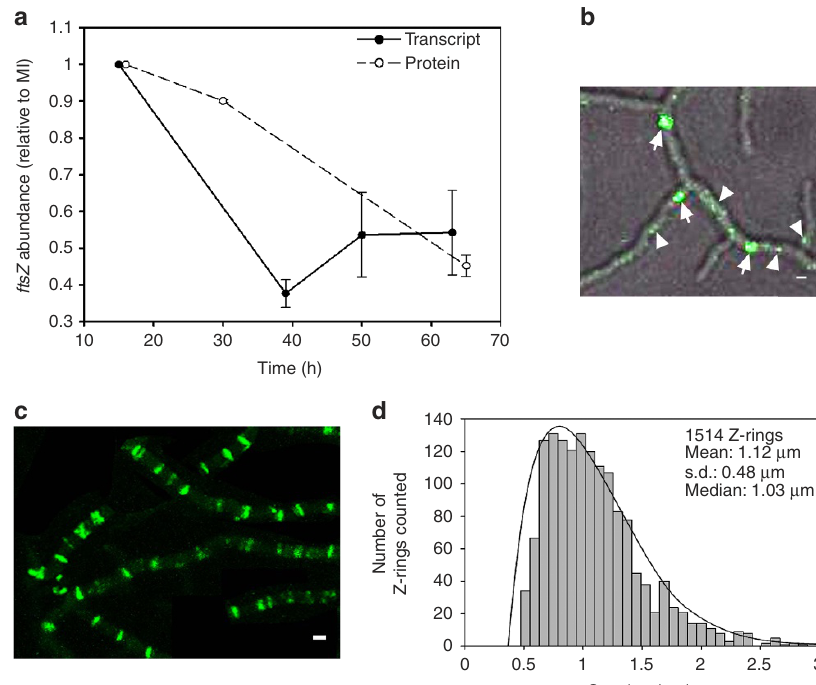
Figure 4 | ftsZ gene expression, protein abundance and cellular localization. ( a ) qRT–PCR analysis of FtsZ mRNA (solid line) and FtsZ protein abundance (dashed line). The average values of three biological replicates are presented (with SD). The MI sample (15h in transcriptomics, 16h in proteomics) was used for normalization and consequently has a value of 1 and an s.d. of 0. All abundance values were significantly different with respect to the 15-h sample ( P value o 0.05; limma analysis 43 for protein; analysis of variance with Turkey’s HSD post hoc analysis for transcript). ( b ) Z-ring formation shown by eGFP- FtsZ at early developmental time points of S. coelicolor grown on GYM agar plates (12h). Fluorescence and phase-contrast images are overlaid. Arrowheads label transitory dynamic spiral-like structures that do not cross the entire diameter of the hyphae. Arrows label Z-rings. ( c ) Maximum projection of the time-lapse experiments (15h); 100% of the hyphae had a regular pattern of Z-rings as indicated by eGFP-FtsZ (see Supplementary Movie 1 and Supplementary Fig. 1). ( d ) Spacing of the Z-rings. The spacing of a total of 1514 Z-rings was analyzed. Scale bars in b and c correspond to 1 m